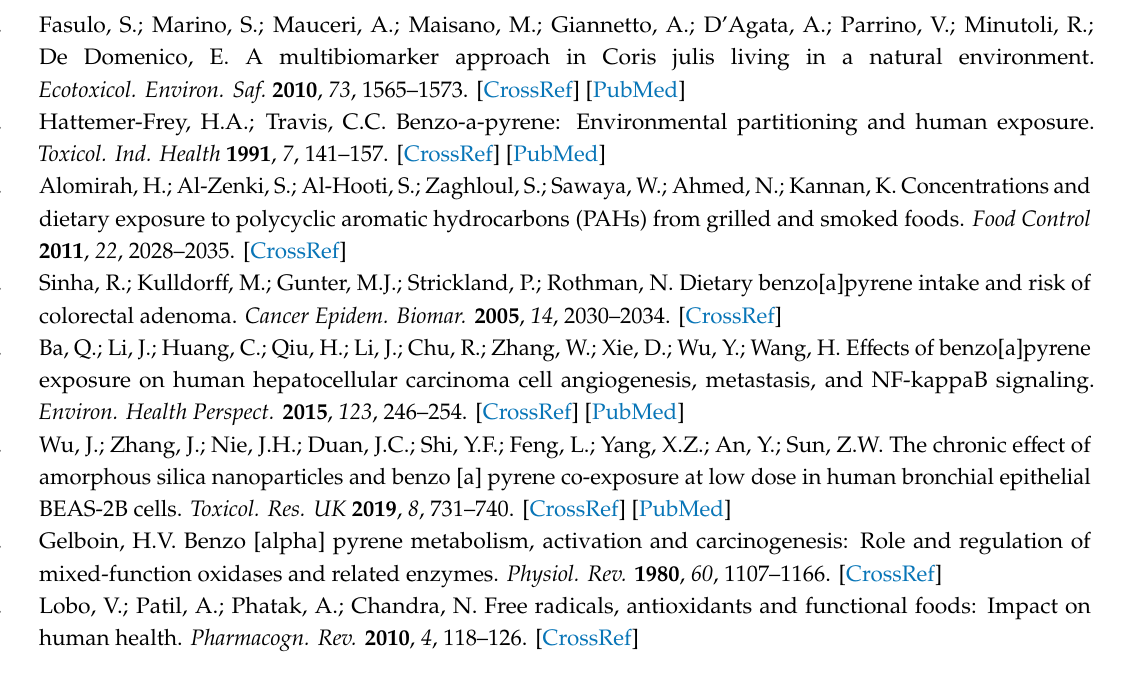
Figure S1: E ff ect of B[a]P and myricetin on body and organ weights. B[a]P (2 mg / kg) alone or together with myricetin (15 mg / kg) was administered to Sprague-Dawley rats orally for 55 days. ( A ) Body weight changes of the rats during 55 days. ( B–E ) Organ weights of the rats after 55 days. M: